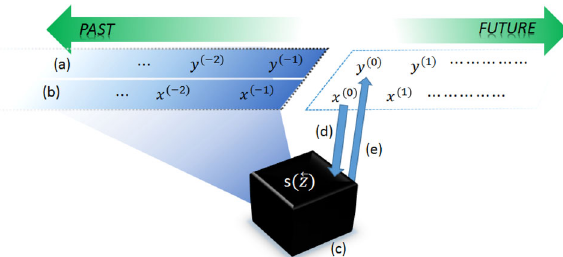
Fig. 1 Modeling a general input – output process. Each instance of an input – output process features some speci fi c sequence of past inputs ( a ) and past outputs ( b ). A model of such a process describes a systematic method of storing relevant information within a physical system ( c ), such that for any future input ( d ), it can replicate the correct statistical output ( e